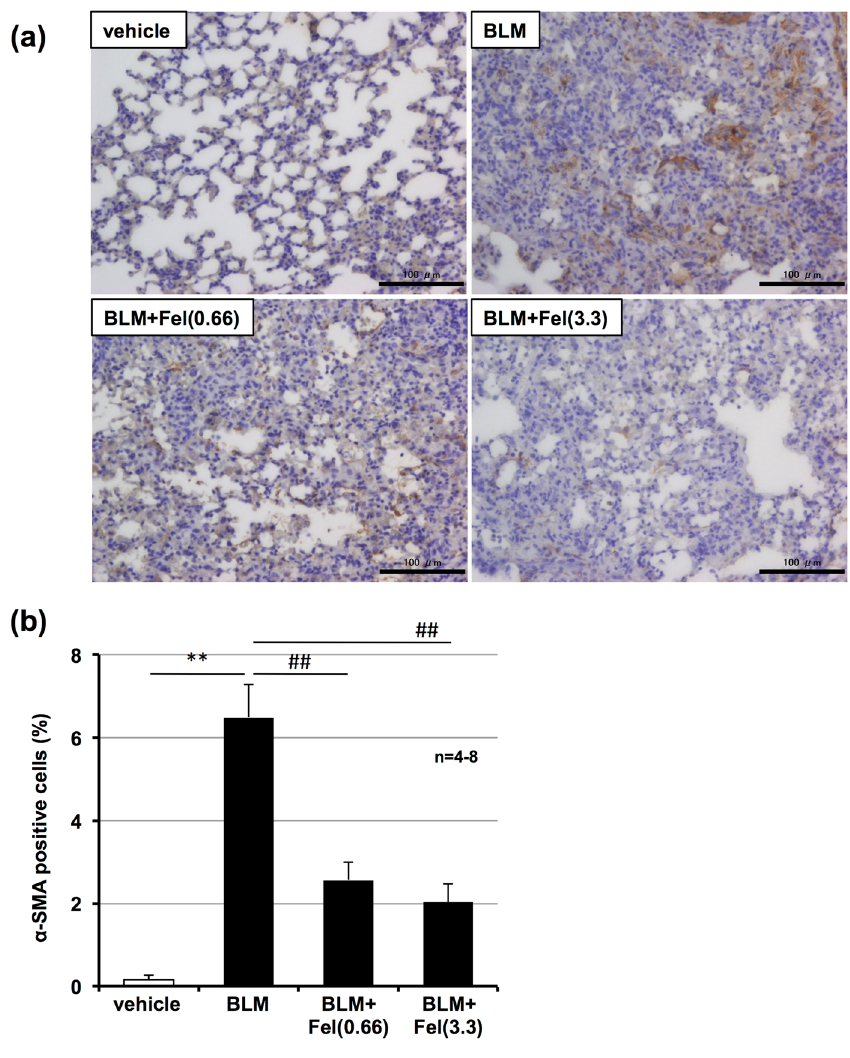
Figure 4. Effect of felodipine on bleomycin-induced increase in myofibroblasts. Mice were intratracheally administered with bleomycin (BLM, 1 mg/kg) or vehicle once only on day 0. Mice were intratracheally administered indicated doses (mg/kg) of felodipine (Fel) once daily for 3 days (from day 10–12). Sections of pulmonary tissue were prepared on day 13 (24 h after final felodipine administration) and subjected to immunohistochemical analysis with an antibody against α -SMA ( a , b ). Scale bar = 100 μ m. Percentage of area stained with antibody was determined using ImageJ software ( b ). Values represent mean ± S.E.M. * * or ## P < 0 . 01 . ( * vs vehicle, # vs